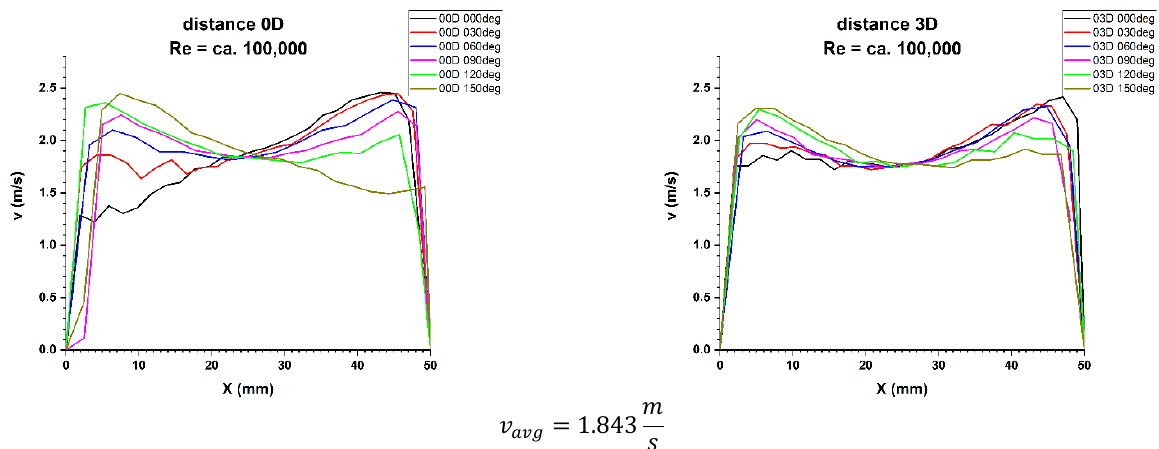
Table 3. Summary of the results of ultrasonic measurements for the 0D plane from the disturbing element as a function of the mounting angle of the ultrasonic flow meter sensors, Re ≅ 70,000.